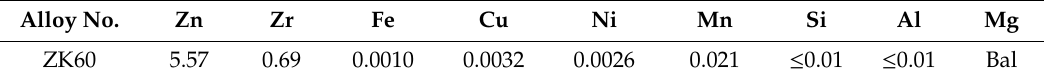
Table 1. Actual composition of ZK60 alloy (w /